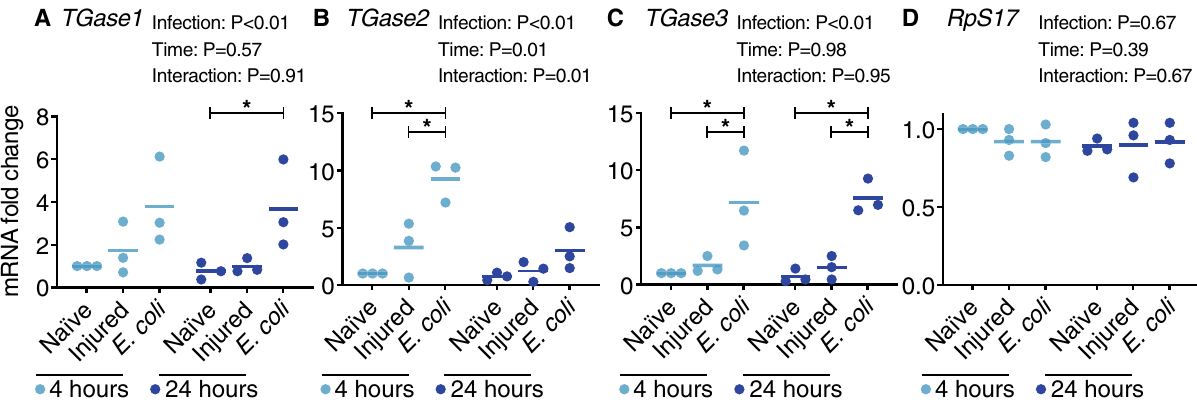
Figure 1. Transglutaminase genes are transcriptionally upregulated following infection. Graphs show the relative mRNA level of TGase1 ( A ), TGase2 ( B ), TGase3 ( C ) and RpS17 ( D ; negative control; RpS17 data is shared with a concurrently conducted study 16 ), in naïve (unmanipulated), injured and E. coli- infected mosquitoes at 4 or 24 h post-treatment. Each circle represents an independent biological trial, and the value is the average mRNA abundance relative to naïve mosquitoes at 4 h across 2–3 technical replicates within the trial. Data were analyzed by two-way ANOVA followed by Tukey’s post-hoc test. Infection P indicates whether infection has an effect irrespective of time, time P indicates whether time has an effect irrespective of infection, and interaction P indicates whether the effect of infection changes with time. The horizontal lines mark the means, and asterisks indicate post-hoc P <